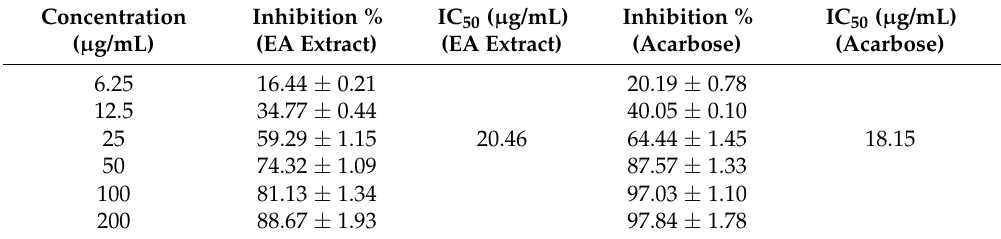
Table 4. α -amylase inhibition and IC 50 values of ethyl acetate extract of Streptomyces sp.S2A. Concentration